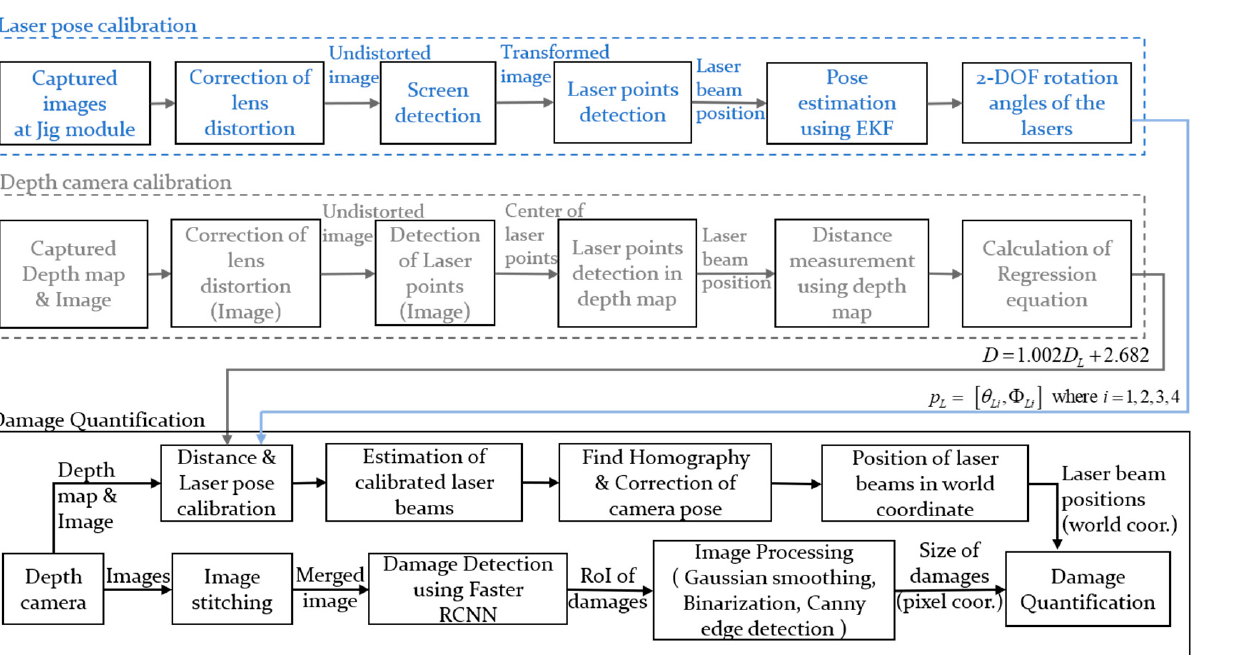
( b ) Figure 3. Image processing for quantification of: ( a ) cracks; and ( b ) delamination and rebar exposure.